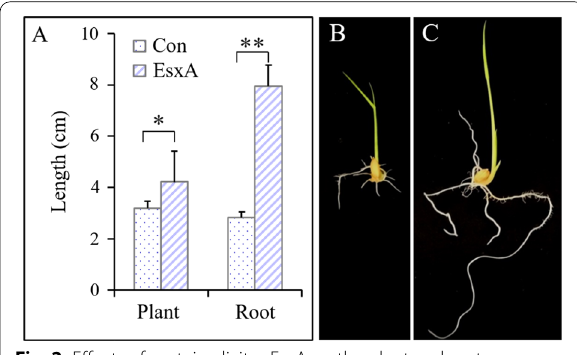
Fig. 2 Effects of protein elicitor EsxA on the plant and root length of rice under seedling blight ( Fusarium oxysporum ) stress (seedling-dipping treatment). Bar diagram A presents the results at 5 days after rice was challenged with Fusarium oxysporum , with “Con” representing the control treatment (without EsxA) and “EsxA” representing the EsxA treatment; B and C represent “Con” and “EsxA” respectively (* P < 0.05, ** P < 0.01))